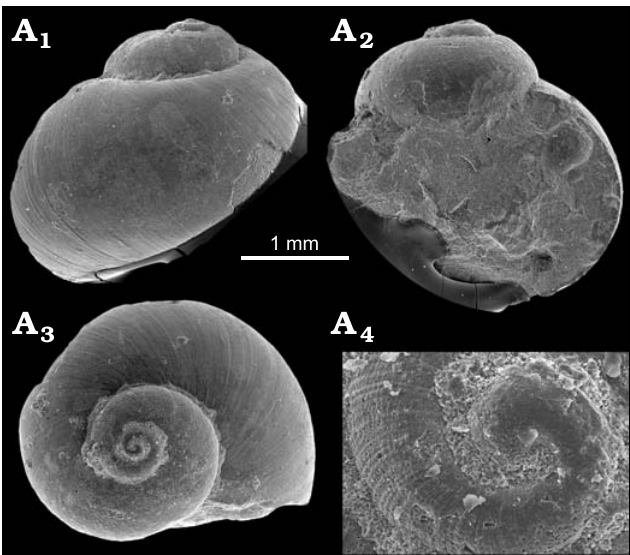
Fig. 10. The possible neomphalid Retiskenea ? sp. (PRI 80014) from the early Cenozoic Lomitos cherts seep deposits near Negritos, Talara Basin, northern Peru.